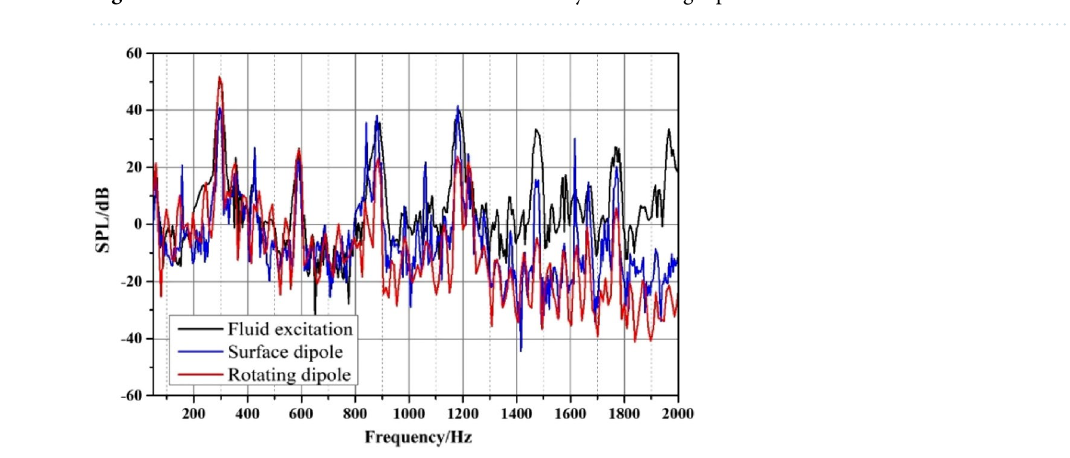
Figure 23. Broadband spectrum of outfield noise by different excitations.